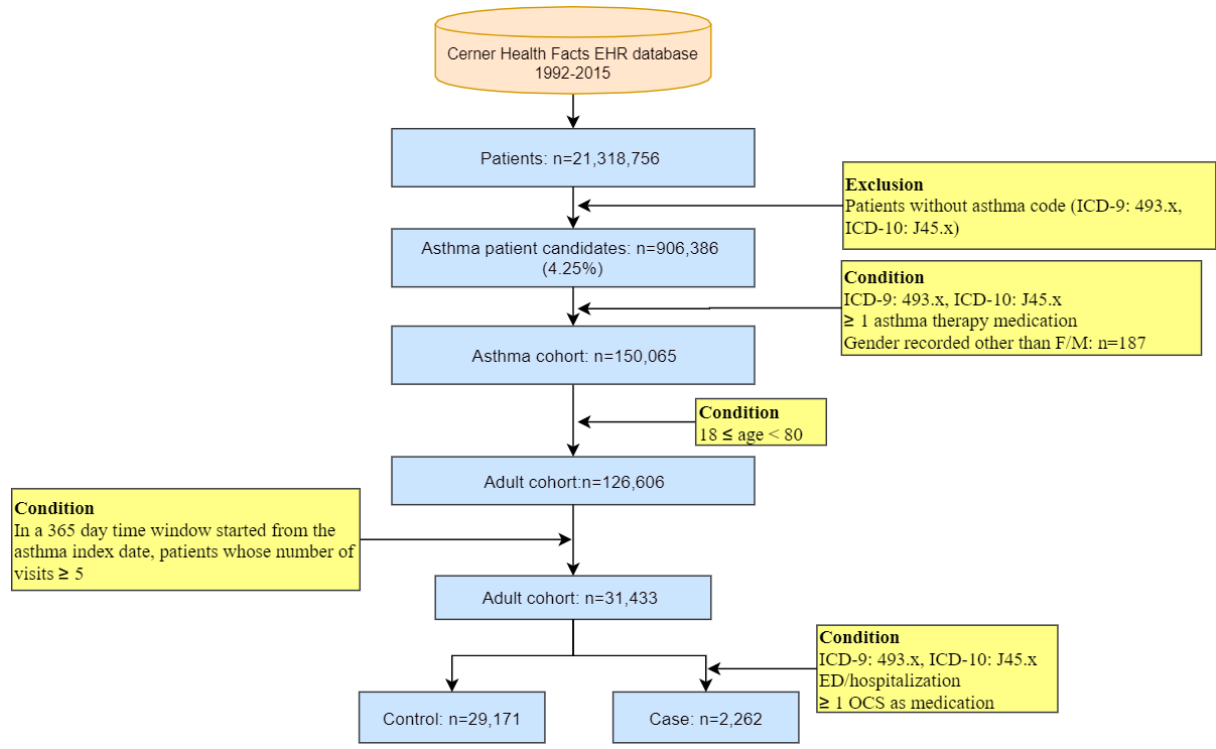
Figure 2. Cohort selection process for the study of asthma exacerbation. ED: emergency department; EHR: electronic health record; ICD: International Classification of Disease Code; OCS: oral corticoids.